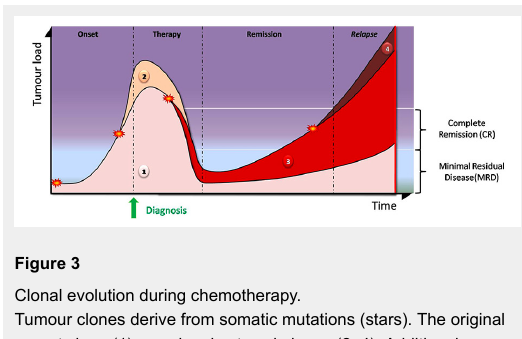
Evolution of tumour load and minimal residual disease (MRD) before, during and after chemotherapy. After therapy, the level of MRD is one of the best predictive factors of relapse. A patient who did not achieve MRD level will relapse very quickly (R0). Depending of the level of minimal disease present, relapse will occur sooner or later (R1, R2, R3). Patients who achieve MRD negativity are considered to be cured and can be maintained in that state with pre-emptive treatment triggered by MRD positive results. The slope of the tumour growth curve is a further predictive factor.